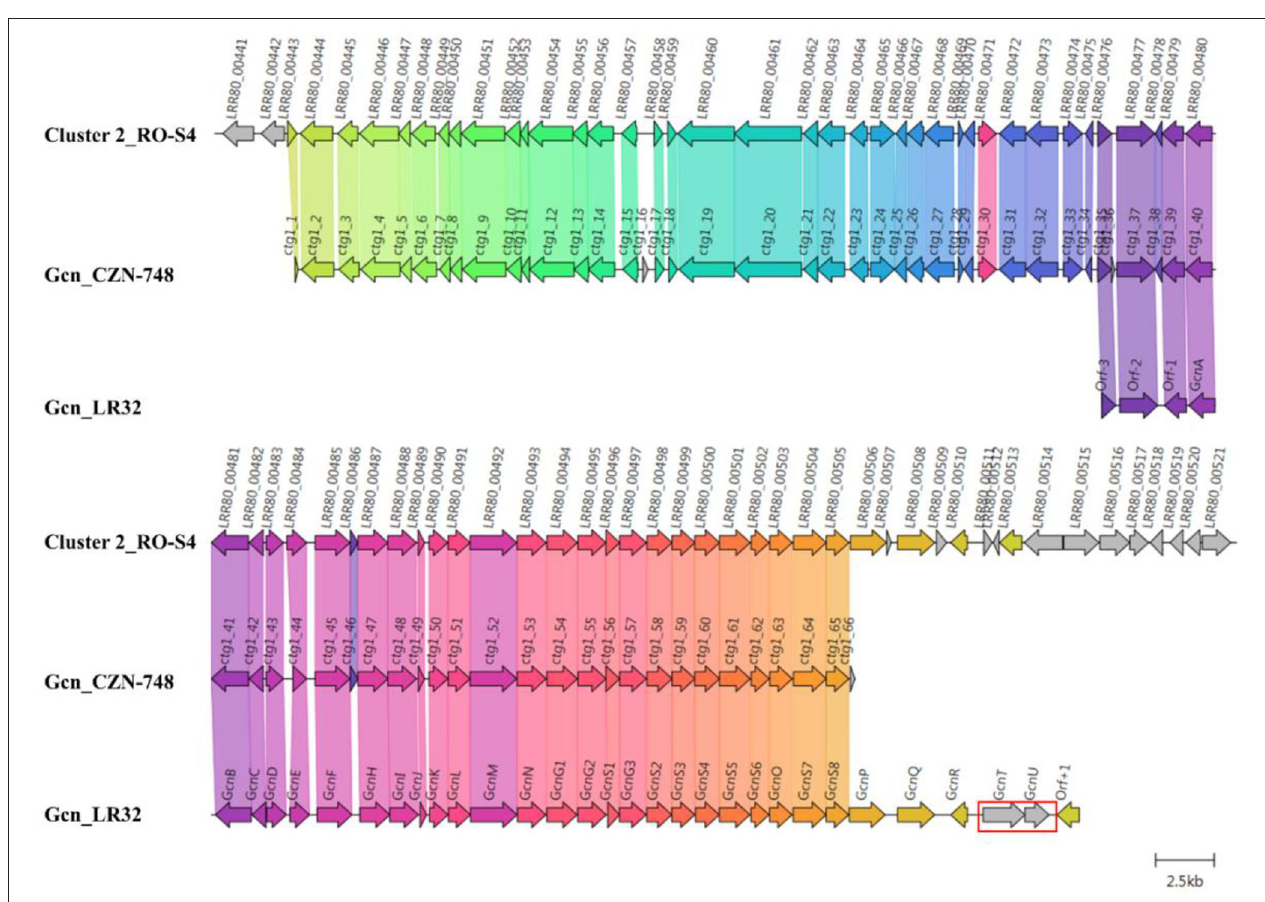
FIGURE 5 | Comparison between Cluster 2 of Streptomyces sp. RO-S4, the Grincamycin Gene Cluster of Streptomyces lusitanus SCSIO LR32, and the BGC of Grincamycin-producing Streptomyces sp. CNZ-748. Gene neighborhoods representative of the compared BGCs are shown aligned with an arbitrary color scheme using clinker to highlight the conserved genes. The arrow’s colors represent the gene clusters identified by Clinker, which encode similar proteins. The lines linking the arrows show gene-encoding proteins that share more than 80% sequence identity. Missing genes in RO-S4 compared to LR-32 were circled in